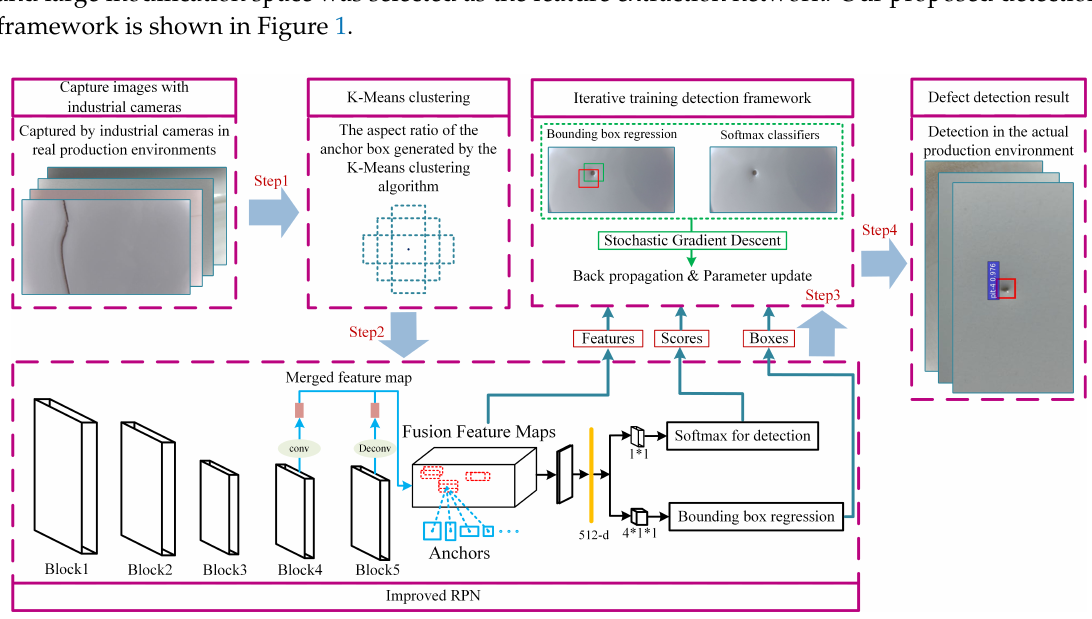
Figure 1. The proposed detection